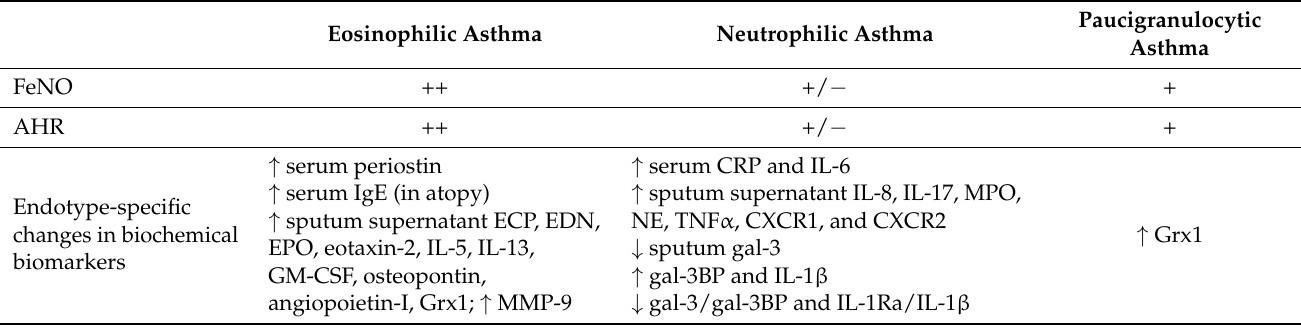
Paucigranulocytic Asthma